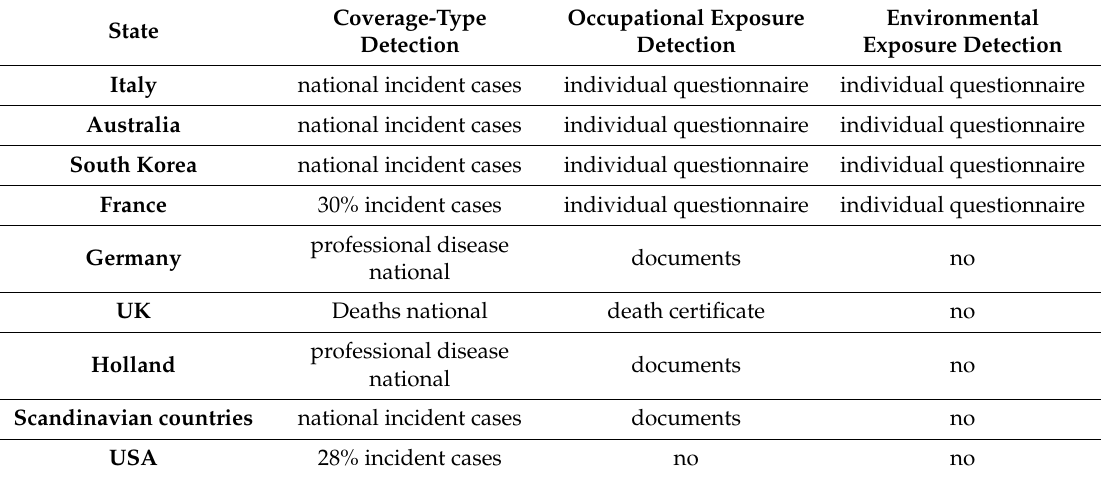
Table 5. International experiences in the epidemiological surveillance of